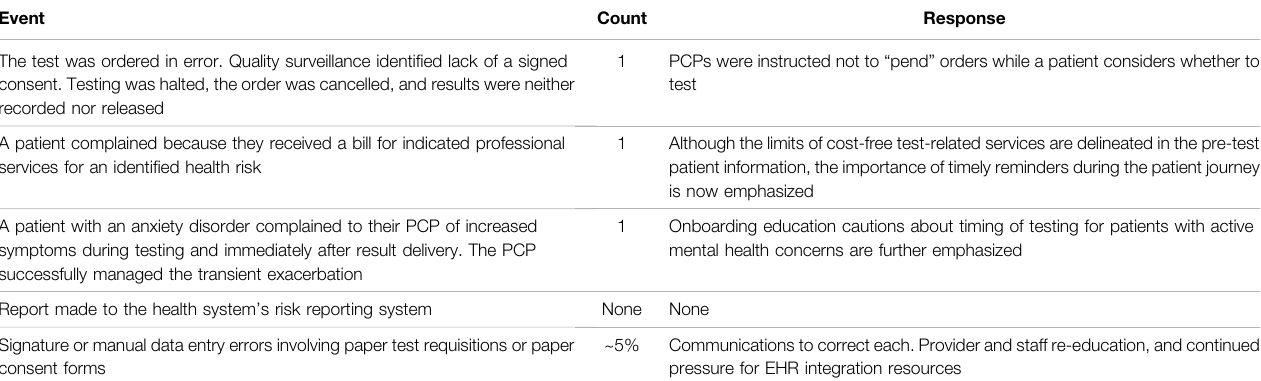
TABLE 2 | Notable Events. Ongoing quality surveillance identi fi ed re fi nement opportunities. Event Count